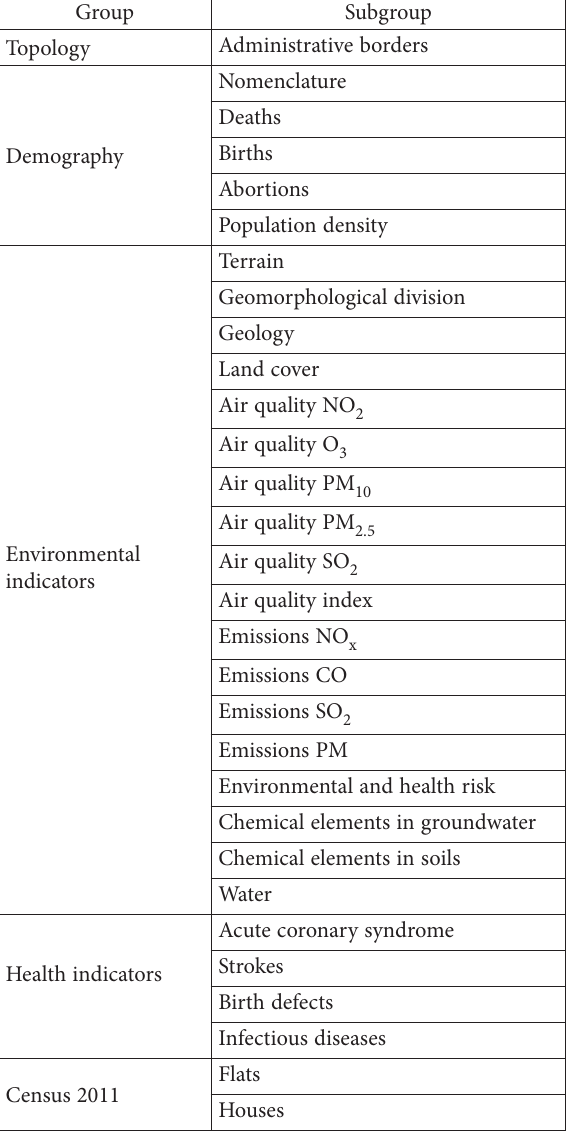
Table 3. Thematic groups and subgroups of data layers in the presented web mapping application for environmental health